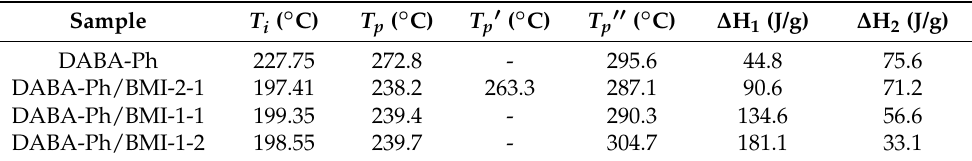
Figure 1. DSC curves of DABA-Ph/BMI copolymers with various proportions. Table 1. Copolymerization behaviors of DABA-Ph/BMI